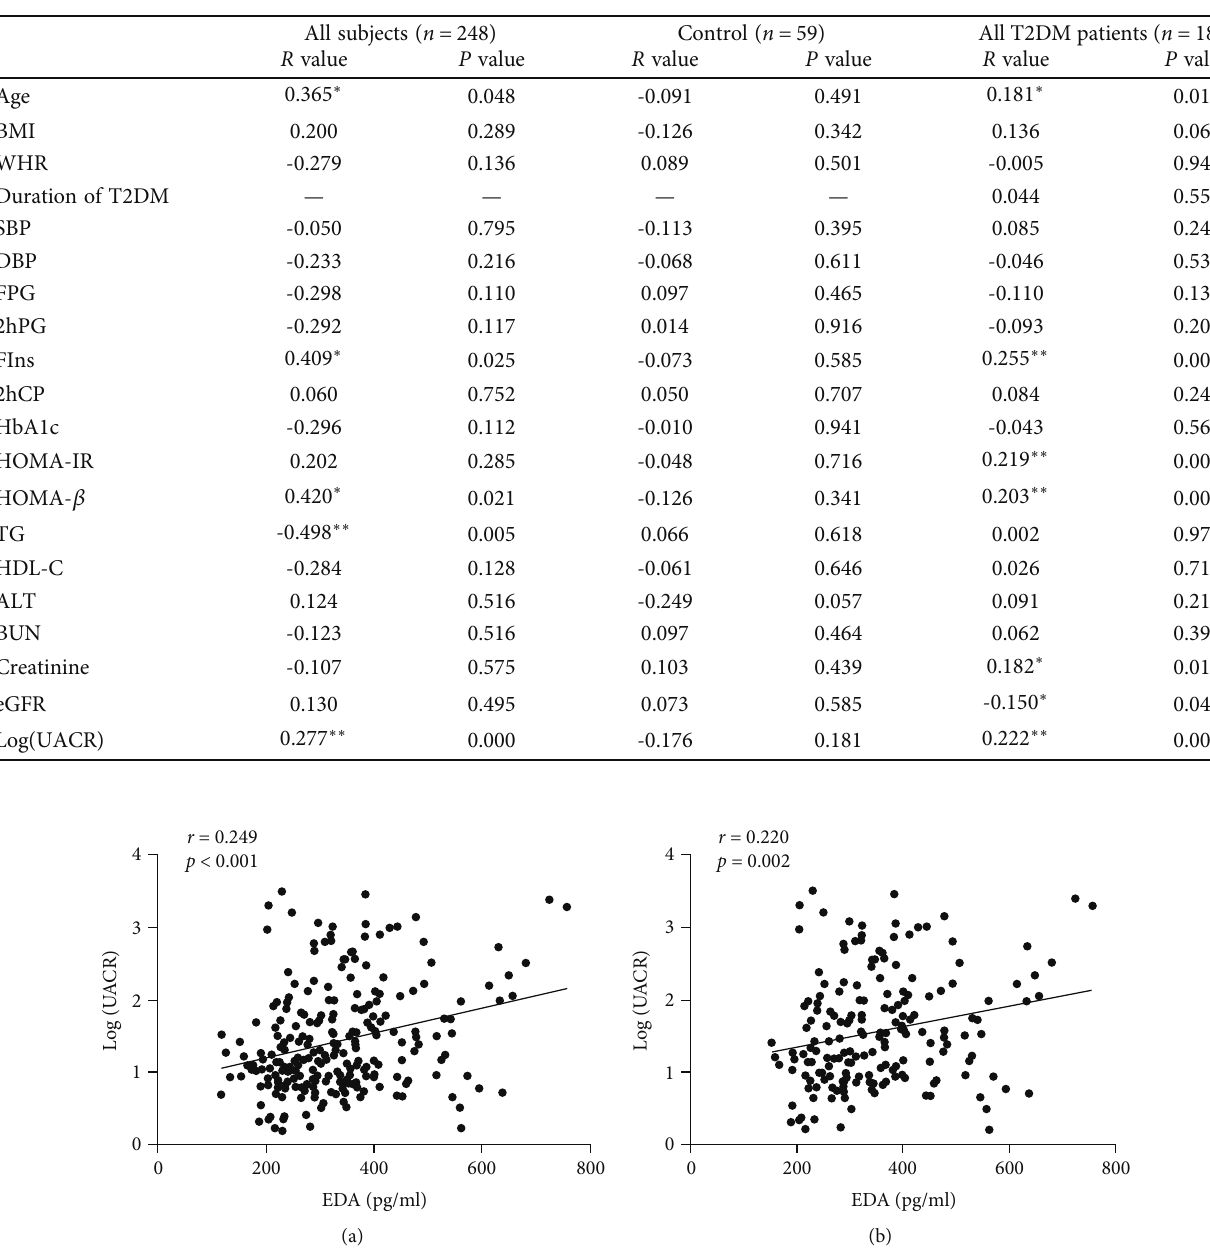
Table 3: The signi fi cant correlations between EDA and clinical indices.